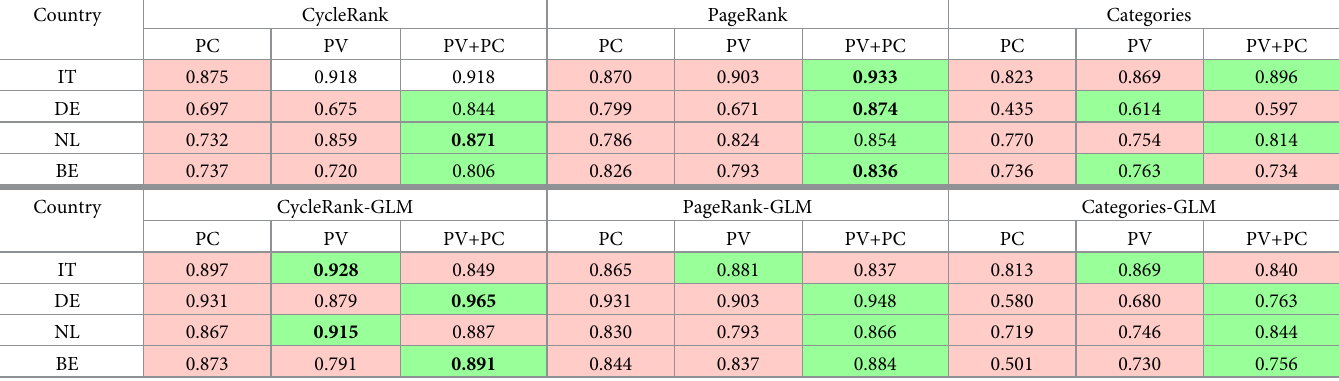
Table 3. Mean Pearson Correlation Coefficient. The bold values indicate the best results over all combinations of models and datasets. The green colour indicates the best results by either using the PC , the PV or the PC+PV dataset, by keeping both the country and the model fixed (no colour means no changes). Country CycleRank PageRank